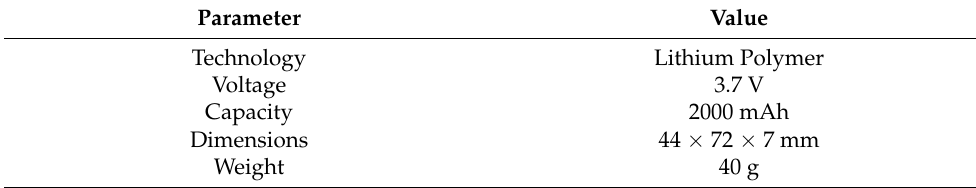
Table 3. Battery main parameters.